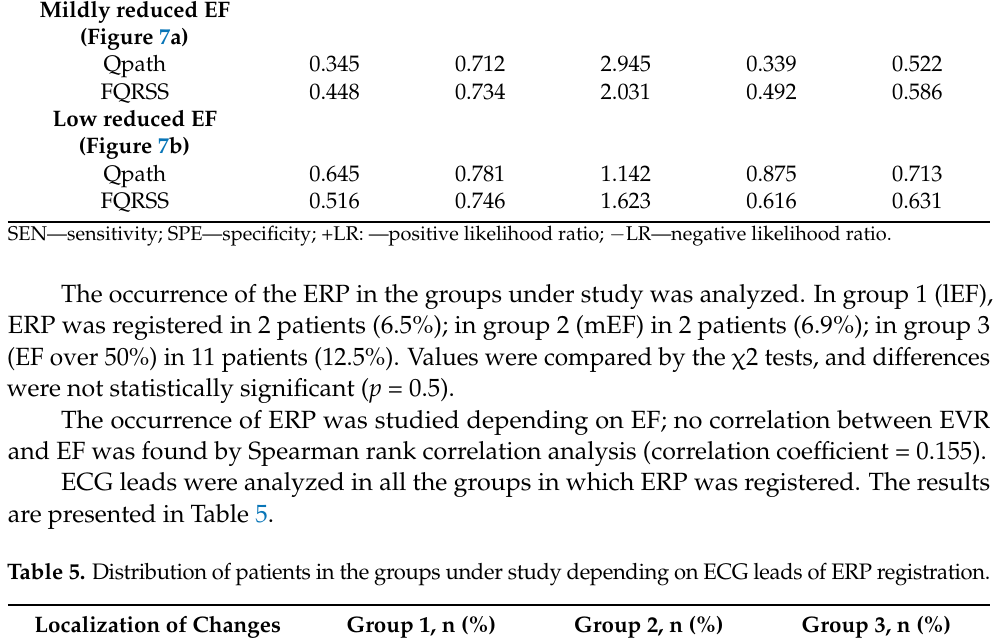
Table 5. Distribution of patients in the groups under study depending on ECG leads of ERP registration.